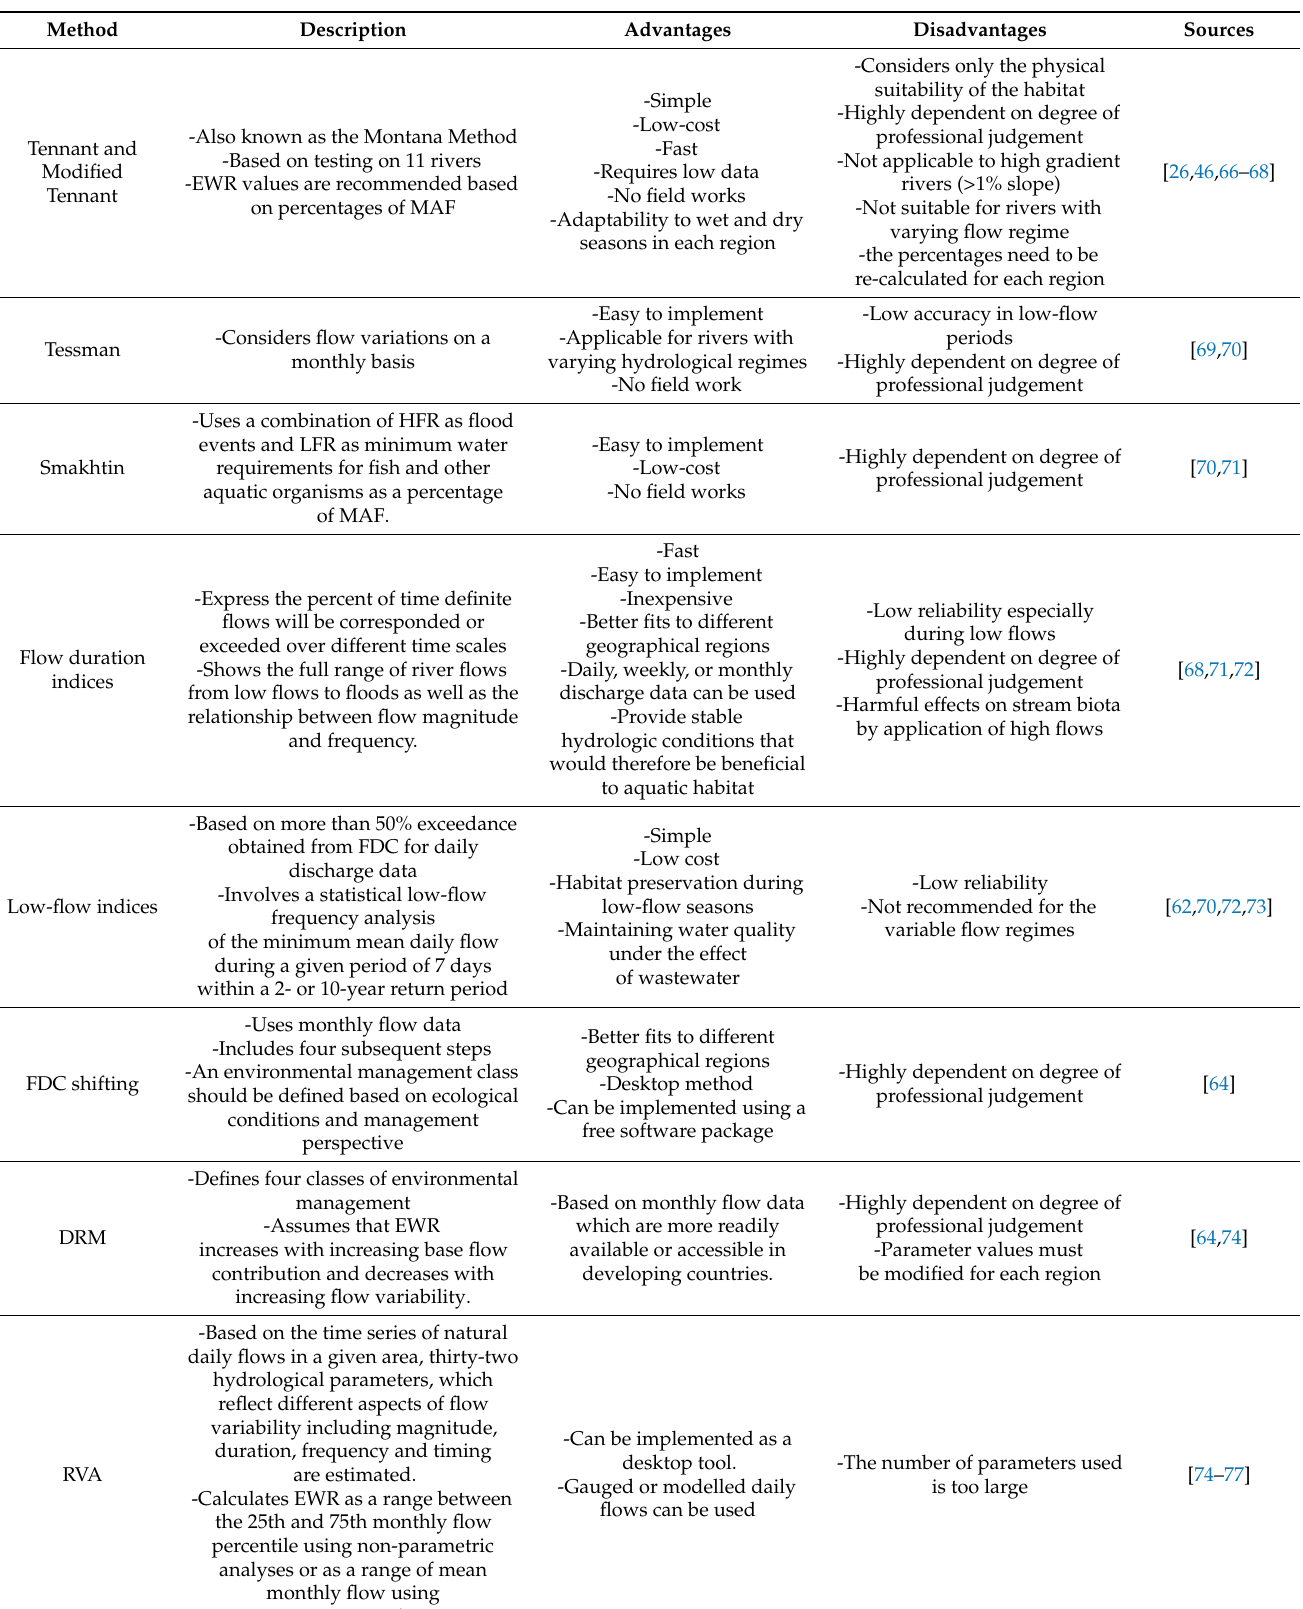
Table 1. A review of some of hydrological methods for the Environmental Water Requirement (EWR)